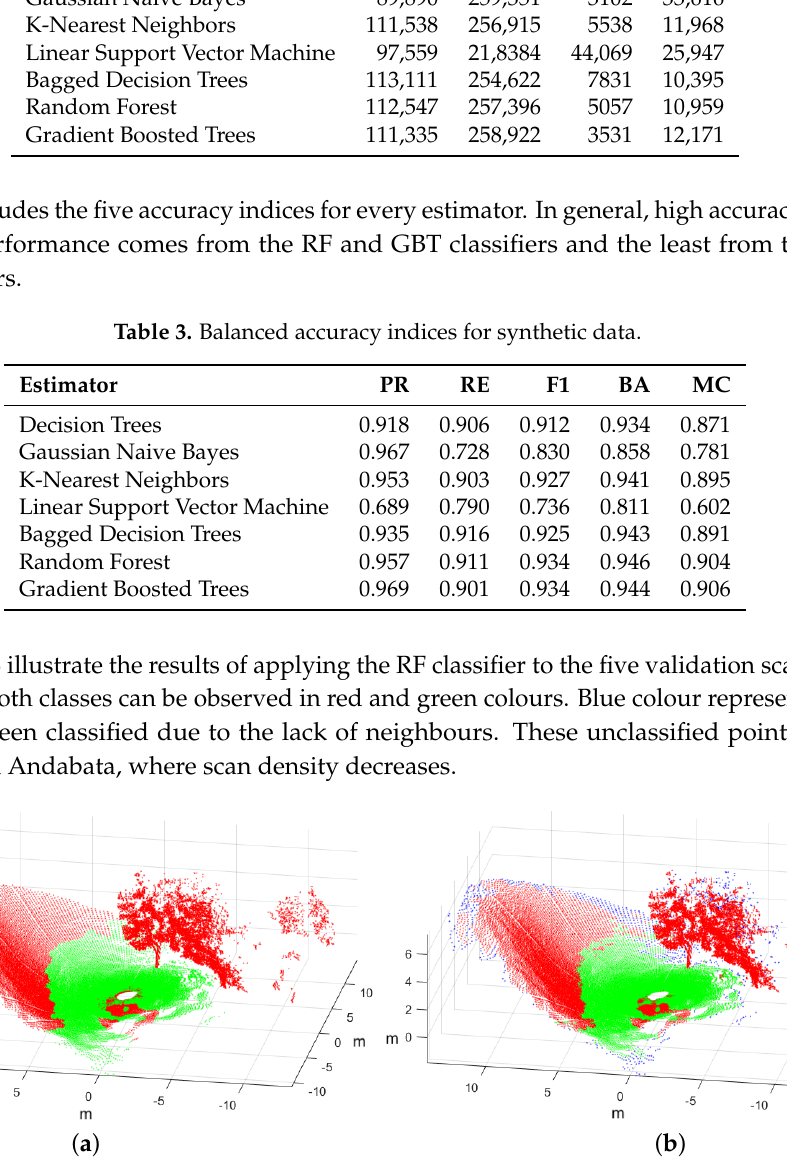
Figure 4. The validation scan on the hills ( a ) and the prediction results with RF ( b